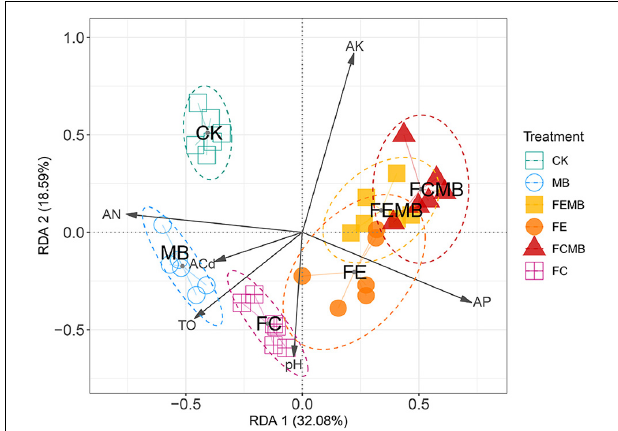
FIGURE 3 | The Bray–Curtis distance-based redundancy analysis (bcRDA) of bacterial ASVs and characteristics of the soil grown with H. cordata under different fertilization regimens. Soil variables: pH, AN (available nitrogen), AP (available phosphorus), AK (available potassium), ACd (available Cd), and TO (total organic